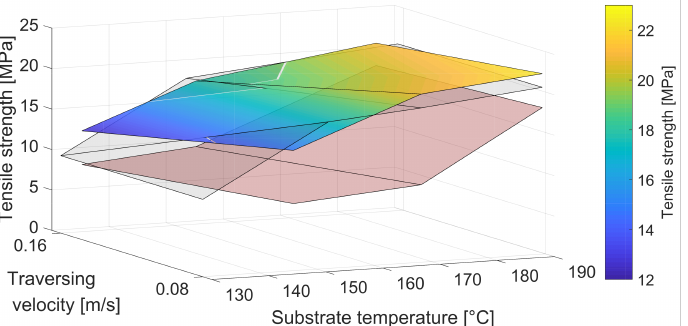
Figure 4. Tensile strength of the heated specimens in the transverse direction with the reference tensile strength for unheated specimens at the same base temperature (red) and the achieved heated temperature (gray).